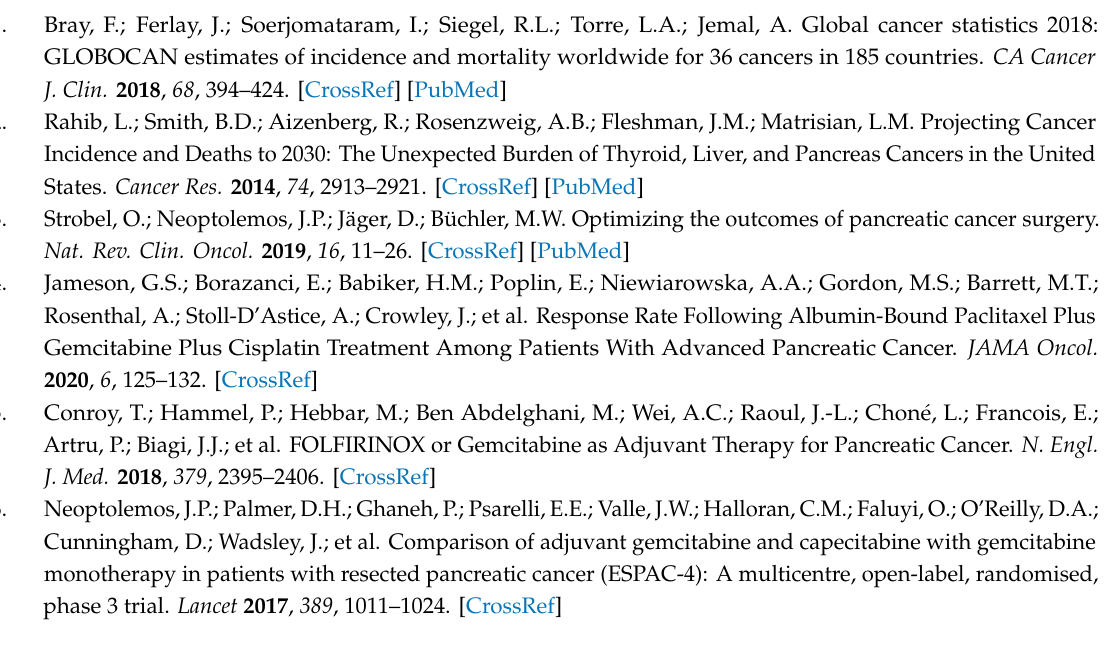
Table S1: List of genes used in the study. Table S2: Mutation annotation format (MAF) file containing variants in PDAC patients’ primary tumors and metastases annotated with Funcotator. Table S3: Top 20 genes scored by FLAGS [31]. Table S4: Variants in KRAS and TP53 genes in primary tumors of PDAC patients. Table S5: Patients divided by the mutational load in driver and druggable or actionable genes. Figure S1: IGV comparison of sequencing and ddPCR results showing reads with uncalled alternative bases. Figure S2: Oncoplot of primary tumors depicting genes significantly mutated in Broad Institute PDAC (a) and LUAD (b) cohorts. Figure S3: The summary of the distribution of variants in three sample pairs of primary tumors and matched pulmonary metastases. Figure S4: Oncoplot of comparison between primary tumors and matched pulmonary metastases depicting genes significantly mutated in Broad Institute PDAC (a) and LUAD (b) cohorts. Figure S5: Overall survival plot of available The Cancer Genome Atlas (TCGA) datasets stratified by KRAS and TP53 mutation status (cBioPortal, refs.